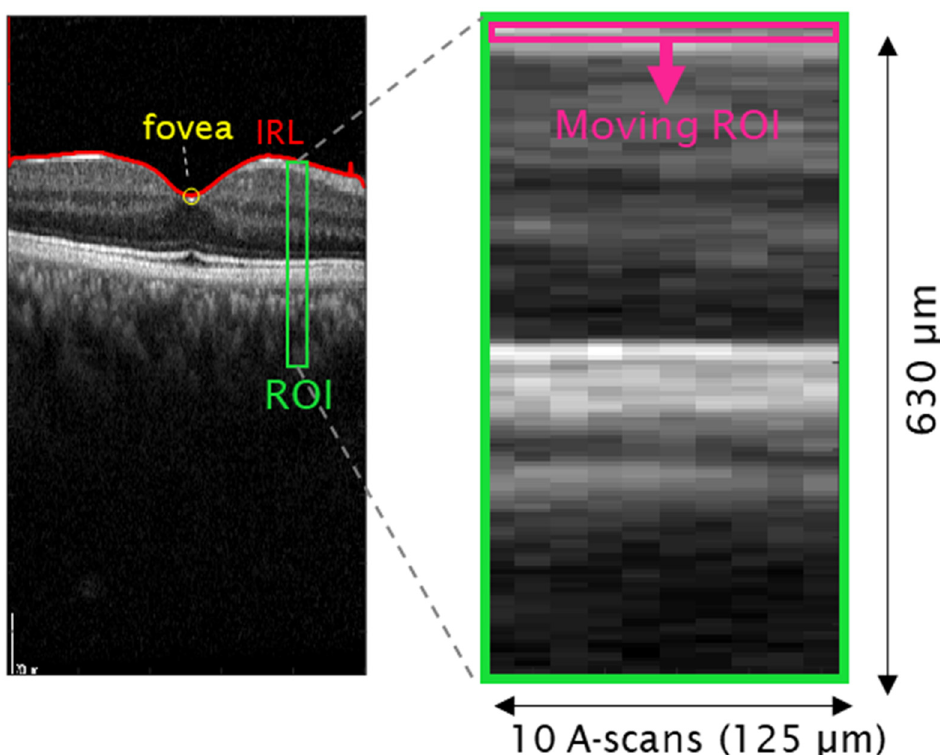
Figure 2. Methodology for speckle contrast estimation from each B-scan. First, image segmentation allows the demarcation of the inner retinal layer border (IRL, red line). Further, the fovea was sought as the minimum of the IRL (yellow circle). The ROI of fixed dimensions 140 × 10 pixels (green rectangle) was approximately set 1.5 mm nasally from the fovea. Inside the ROI a moving ROI of fixed dimensions 1 × 10 pixels and a moving step of 1 pixel was set (pink rectangle). The pink arrow indicates the continuation of the process.